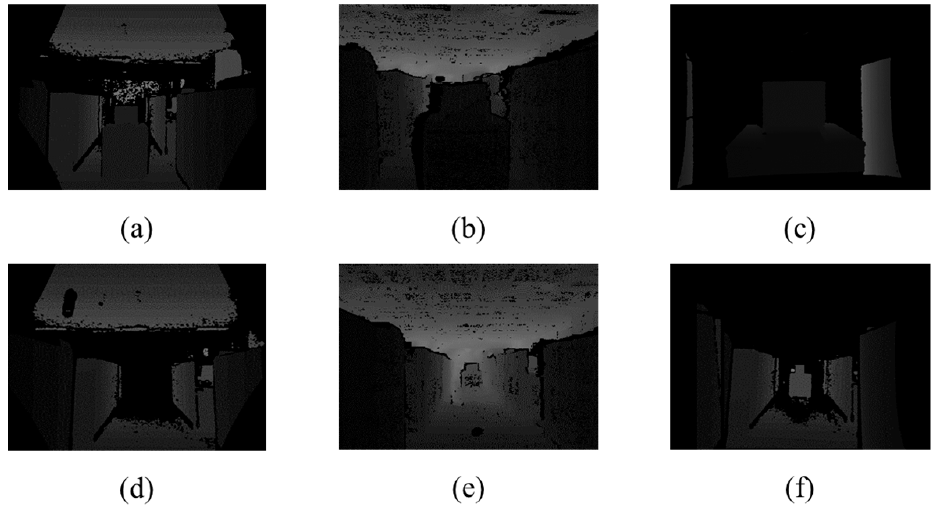
Figure 5. Depth map from various sensors: near distance example of ( a ) ToF sensor; ( b ) stereo camera; ( c ) proposed method; far distance example of ( d ) ToF sensor; ( e ) stereo camera; ( f ) proposed method.